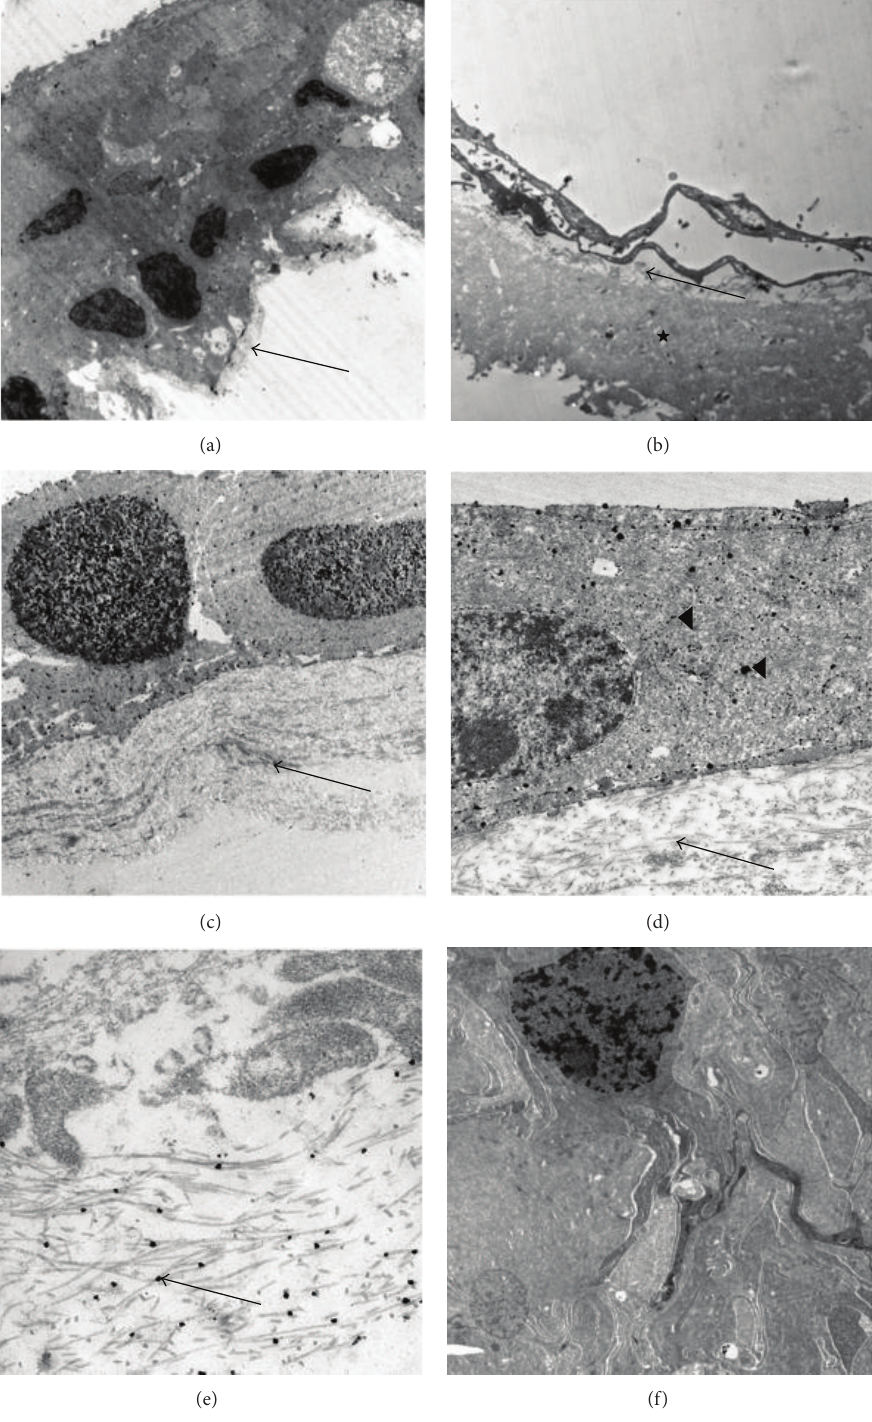
Figure 3: Transmission electron micrographs of lamellar hole-associated epiretinal proliferation (LHEP) with immunonanogold application following gold enhancement preparation procedures. (a) Densely packed cell agglomeration of fibroblasts and hyalocytes situated on a thin strand of vitreous collagen (arrow). (b) Internal limiting membrane (big star) with small vitreous collagen deposits (arrow) and fine cellular processes on the vitreal side. (c, d) Native vitreous collagen (arrow) with GFAP-positive fibroblasts as demonstrated by immunonanogold staining (arrowhead). (e) Small black dots (arrow) represent immunonanogold particles staining collagen type II of vitreous cortex collagen. (f) Negative control specimen with typical dense epiretinal cell proliferation seen as cell agglomeration of fibroblast-like cells. (Original magnification: (a) × 3,000; (b) × 4,400; (c, f) × 7,500; (d) × 18,000; (e) ×